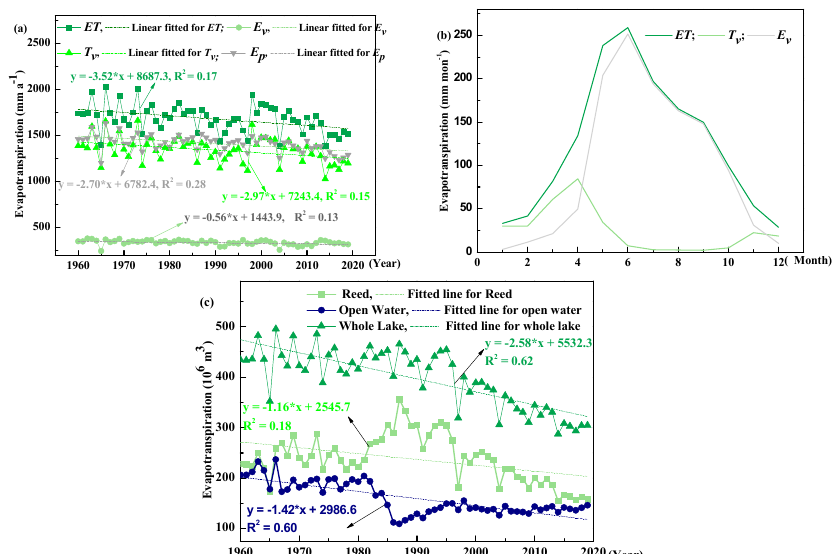
Figure 5. Variation in annual ( a ) and monthly ( b ) evapotranspiration ( ET ) and potential evaporation ( E v ), potential transpiration ( T v ) and potential evaporation ( E p ) in Baiyangdian Lake. Annual evapotranspiration ( ET ) for reed, open water, and whole lake showed ( c ). This figure also provides linear fitted slopes for ET , E v , T v and E p and for ET for the entire lake and open-water area and P. australis cover.